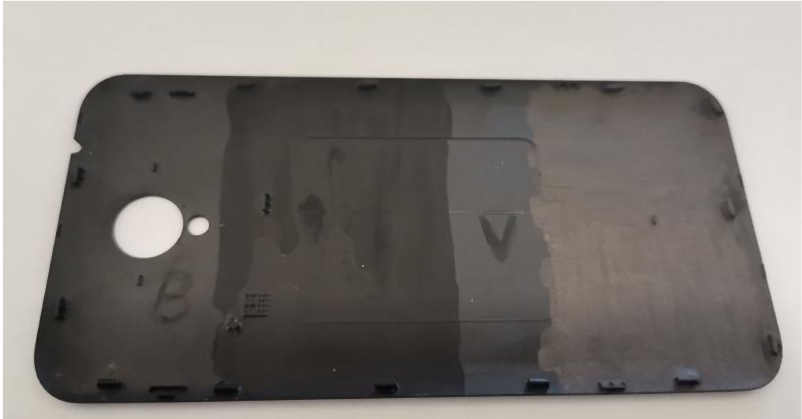
Figure 12. Cellular phone back side chassis coated with 2 paints